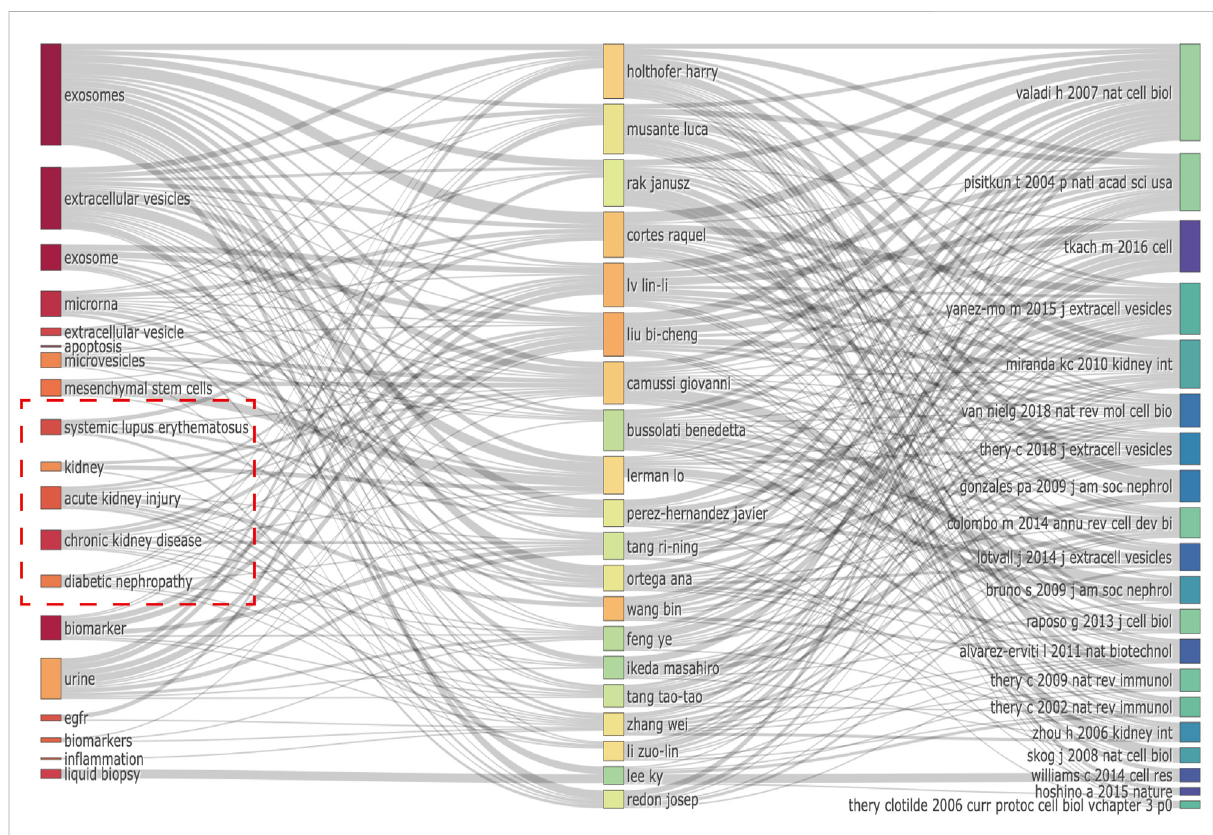
FIGURE 6 Relationship of the top 20 co-cited references, authors, and keywords evolution based on an alluvial fl ow map by R.